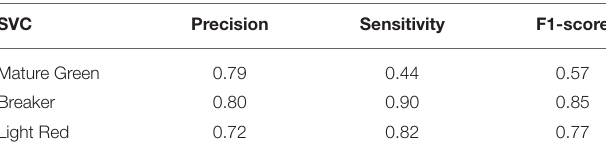
TABLE 3 | Precision, Sensitivity, and F1-score of the SVC model to Mature Green, Breaker, and Light Red classification. SVC Precision Sensitivity F1-score Mature Green 0.79 0.44 0.57 Breaker 0.80 0.90 0.85 Light Red 0.72 0.82